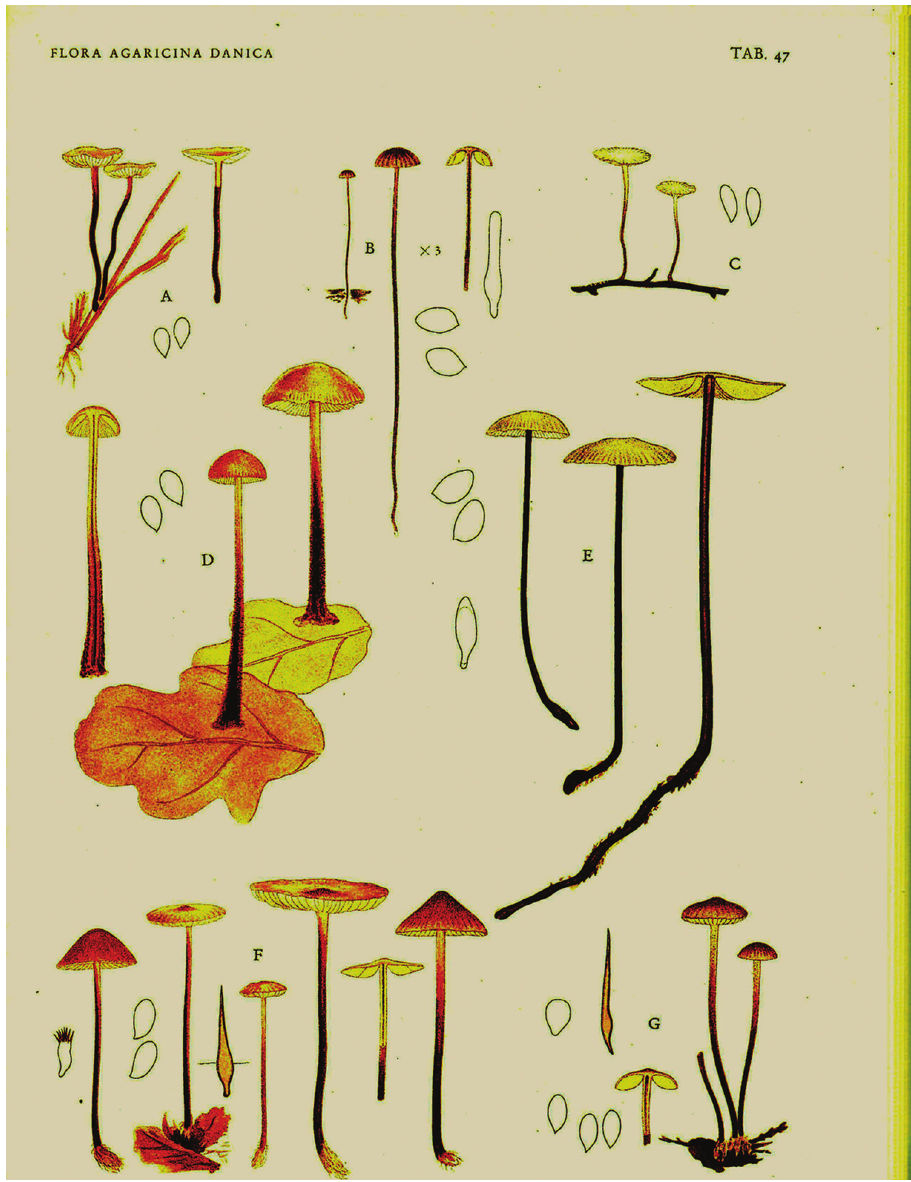
Figure 99. Lange’s plate, including M. prasiosmus